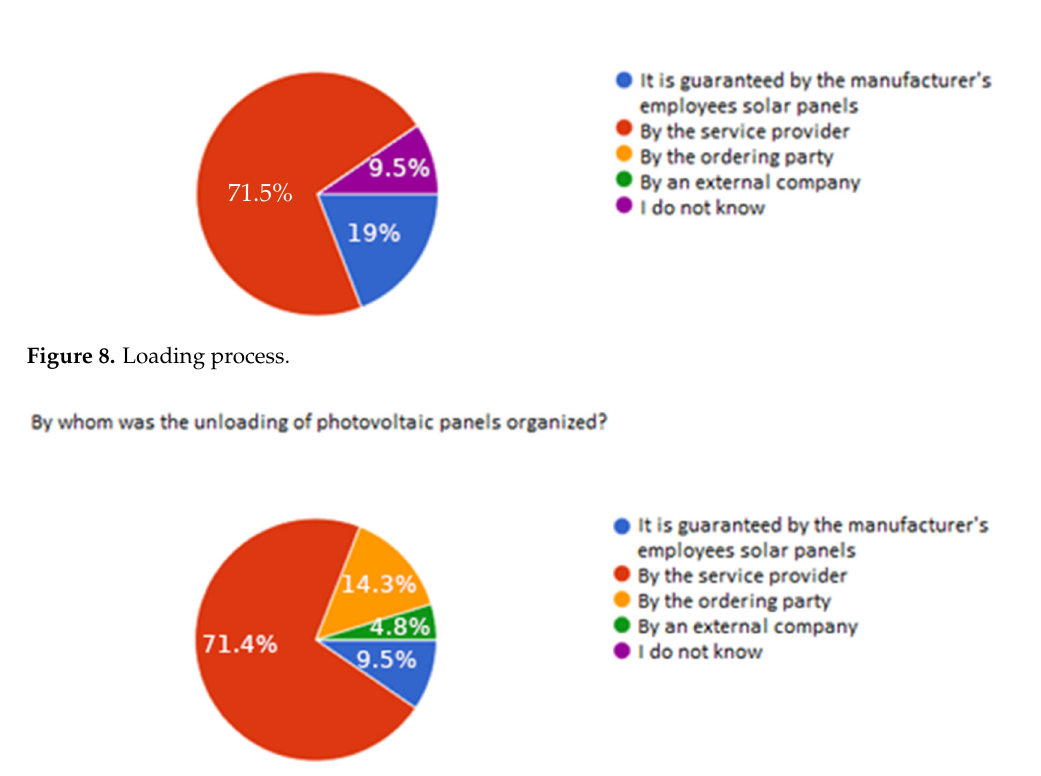
Figure 11. Packaging methods for photovoltaic panels. 3.3. Storage Process The next considered logistic process was warehousing, which in the literature is de- fined as receiving and issuing goods from a warehouse, storing goods, order picking and administering warehouse space [21]. In the example we are discussing, the storage con- cerns mainly the storage of the generated energy by a home solar power plant and the cases of storage of the power plant components on the property of the contracting author- ity before their installation at their destination. In the first place, questions were asked about the place of installation of the panels, then about the information about the possi- bilities of energy storage and their choice by the respondents and about the method of storage of the panels before their installation [10] (Figure 12).